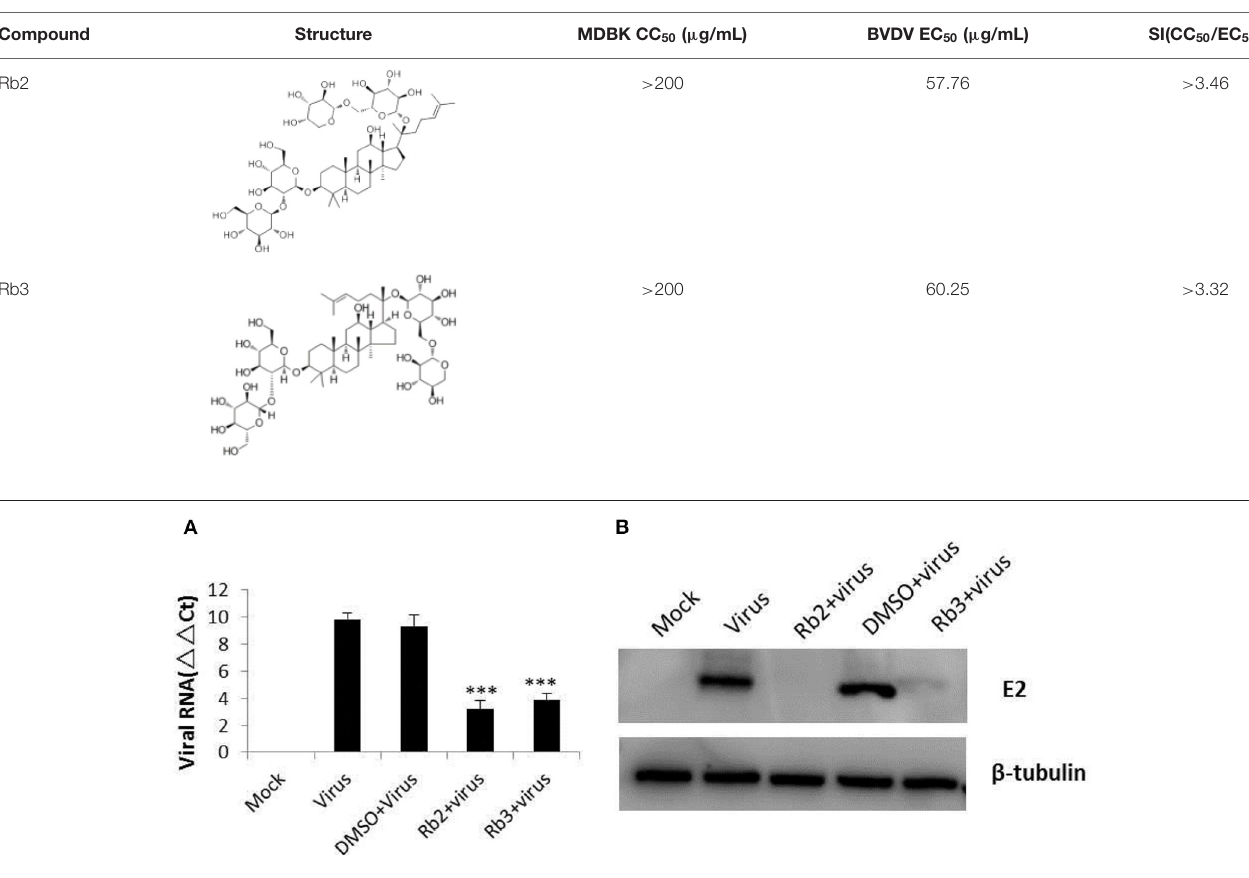
FIGURE 5 | Effect of ginsenoside Rb2 and Rb3 on BVDV replication. (A) Real-time PCR analysis of the viral RNA. (B) Western blot analysis of BVDV E2 protein expression. Uninfected cells and DMSO-treated cells were used as control. *** p < 0.001.